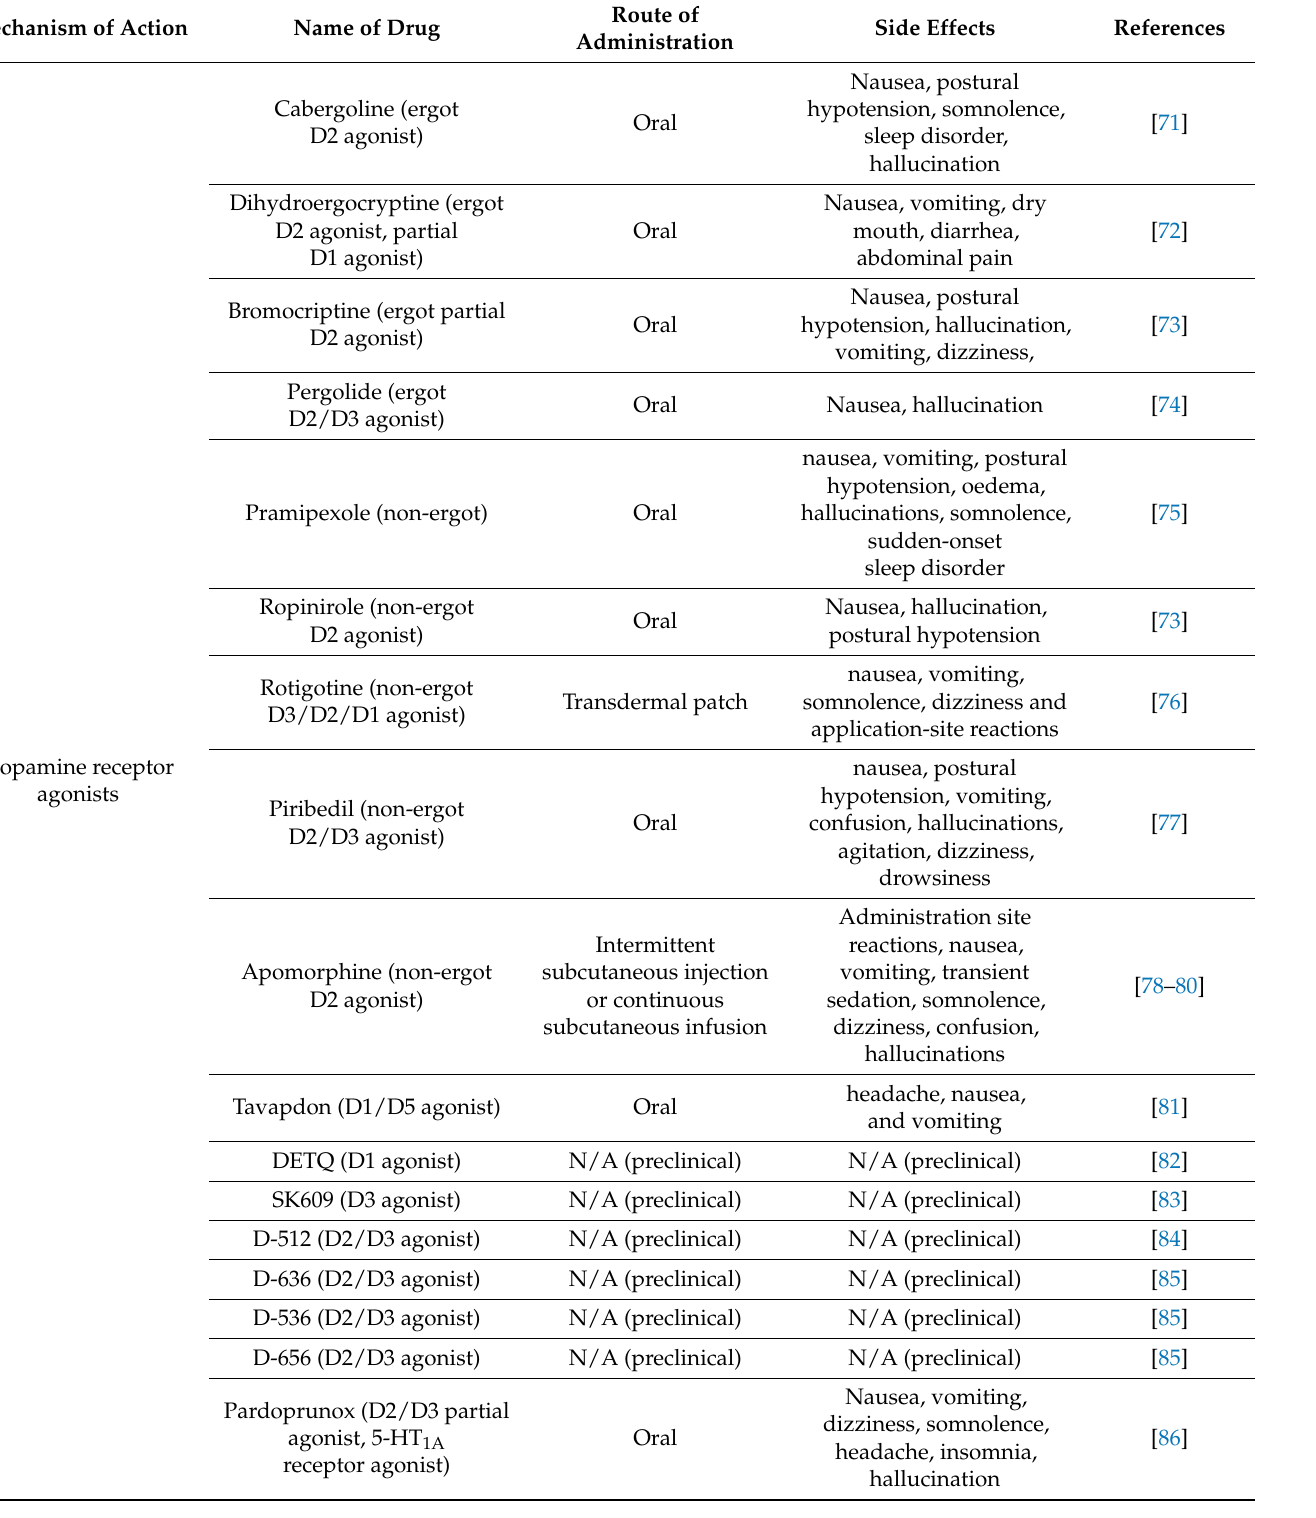
Table 2. Levodopa Adjunctive Dopaminergic